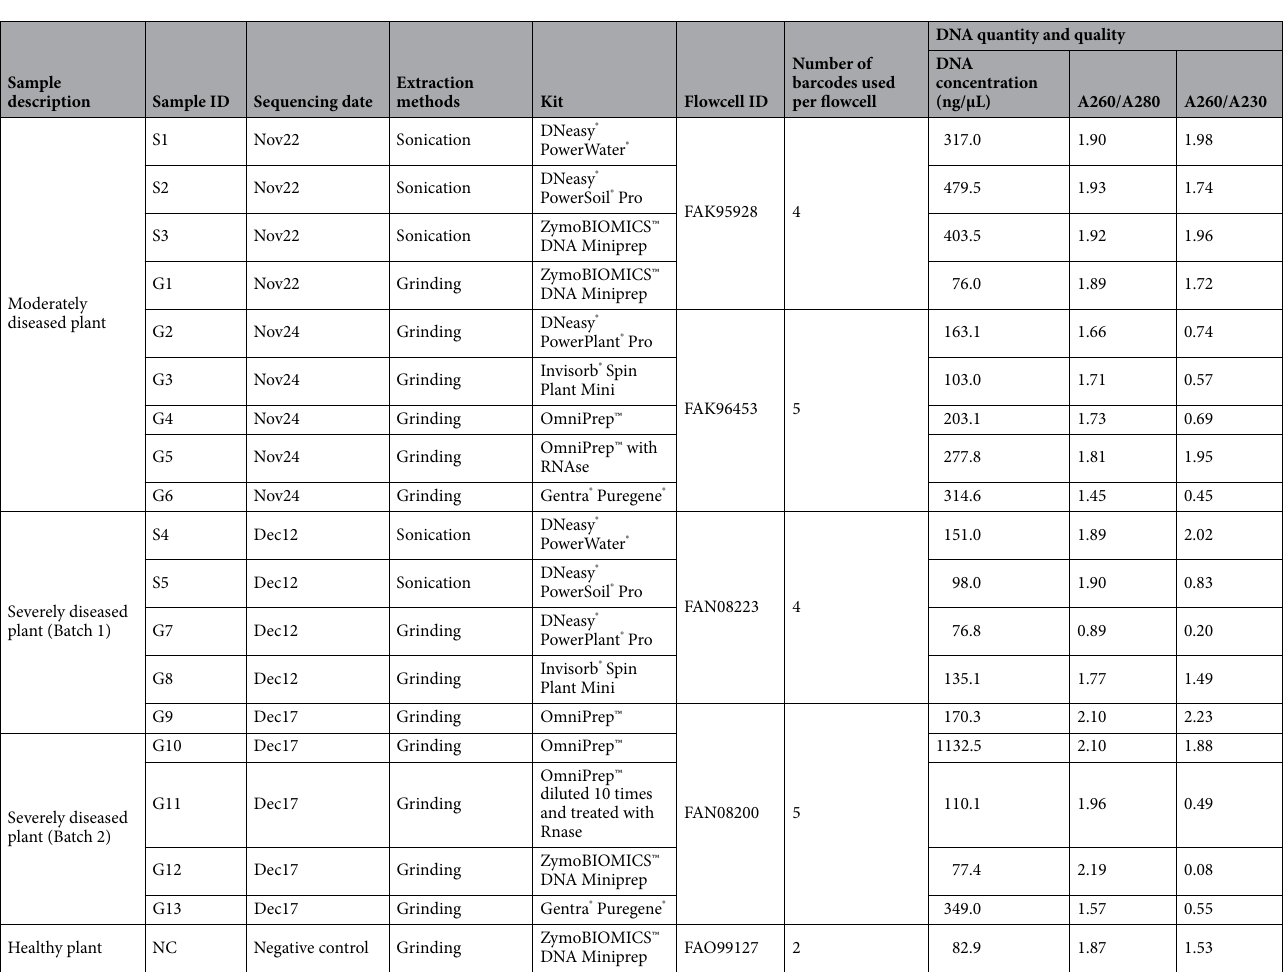
Table 1. Metadata and DNA quantity and quality of samples used in this